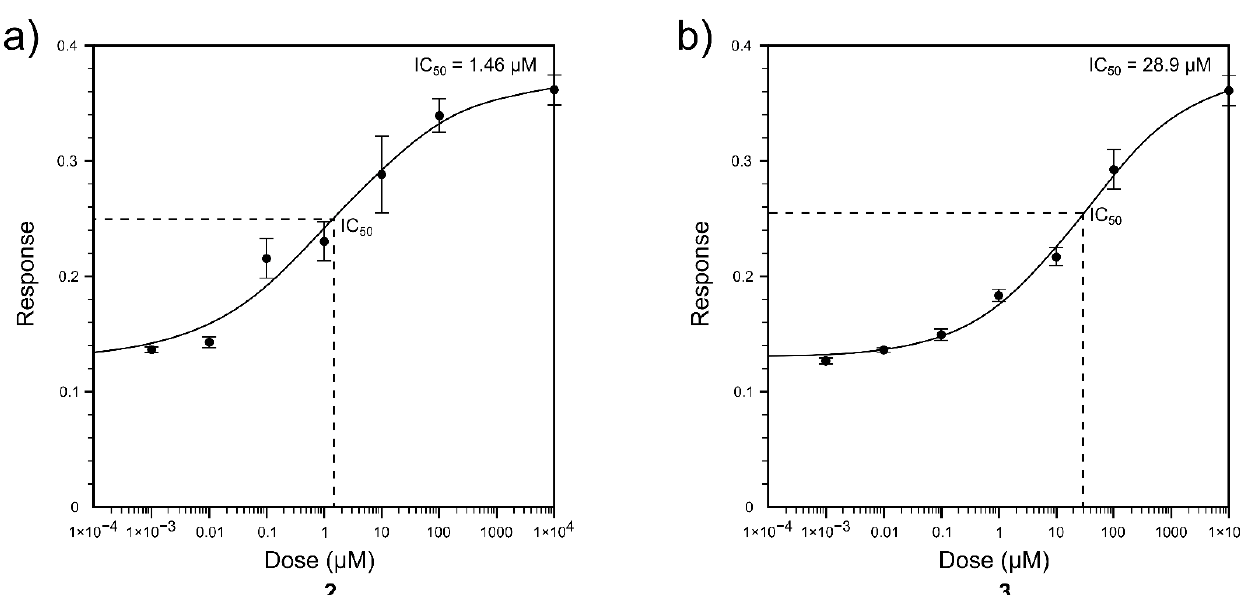
Figure 5. Inhibitory effect of the compounds 2 ( a ) and 3 ( b ) on the demethylation of the probe RNA by FTO. Response reflects the m 6 A level in probe.